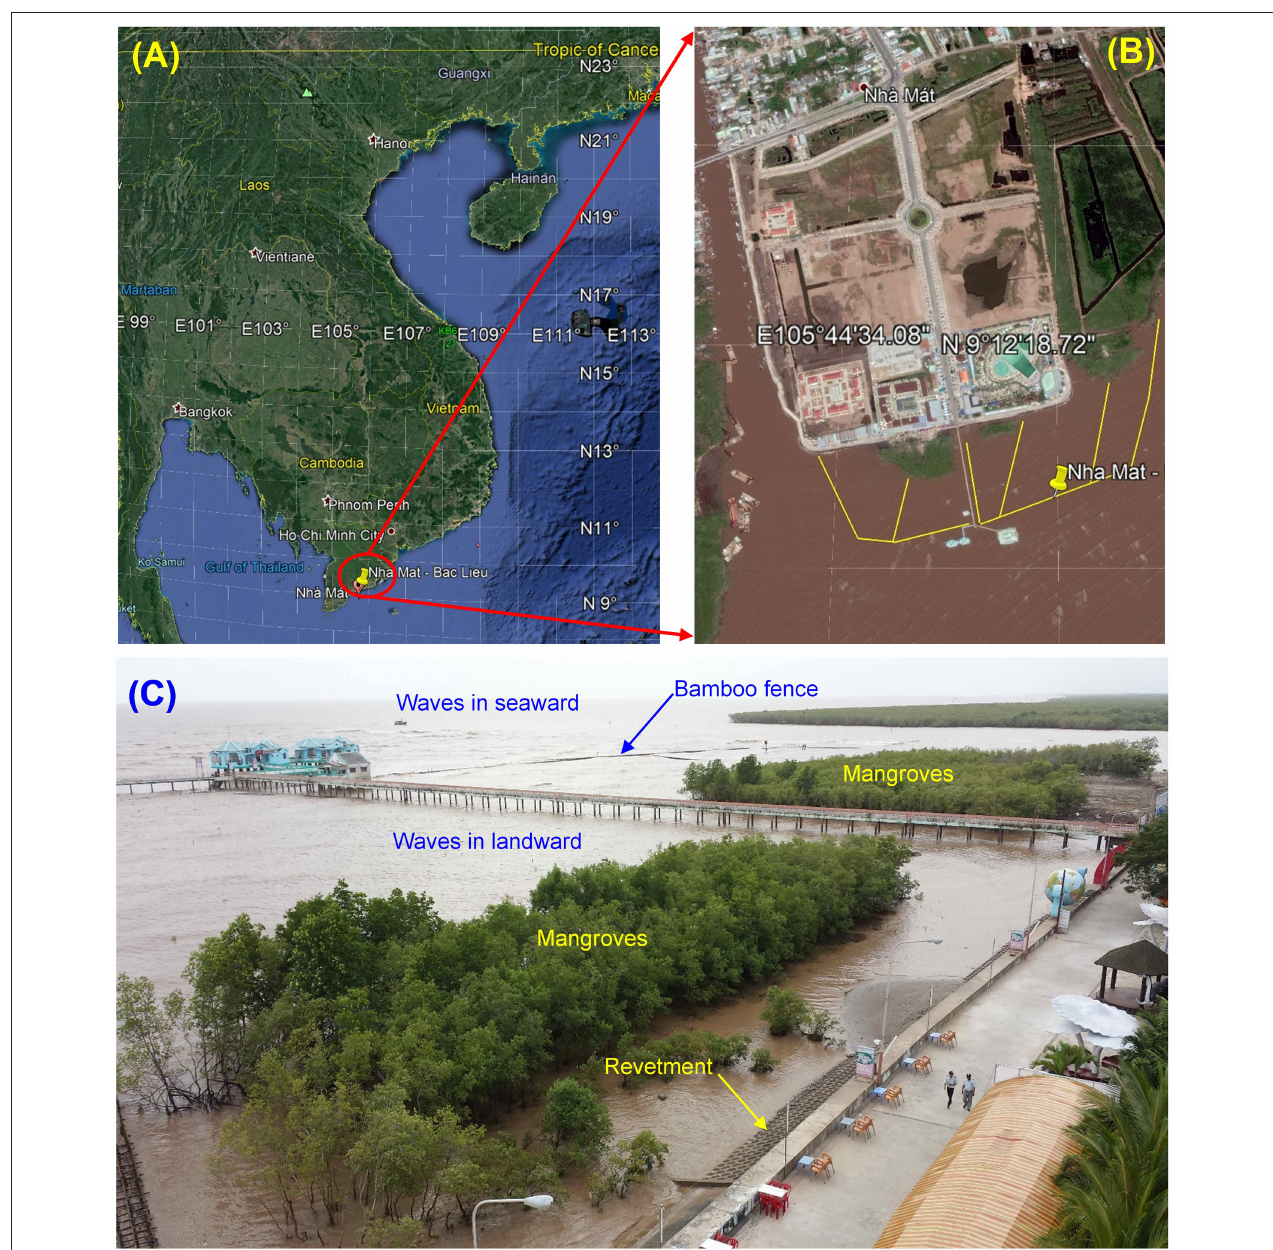
FIGURE 1 | The study area in Nha Mat ward, Bac Lieu City in Vietnam: (A) Vietnamese coast; (B) Nha Mat coast; (C) A photo taken at Nha Mat coast.